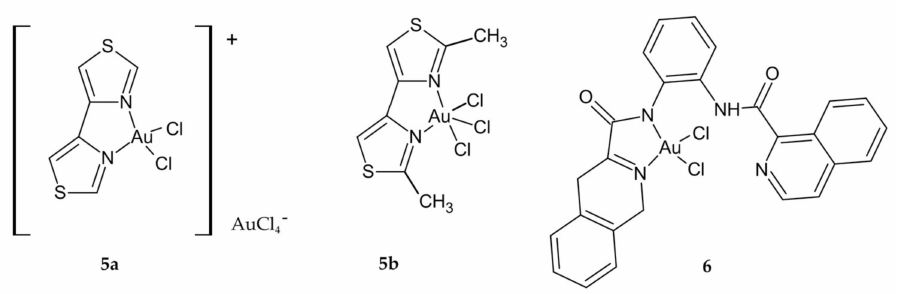
Figure 3. Au derivatives 5a , b and 6 .